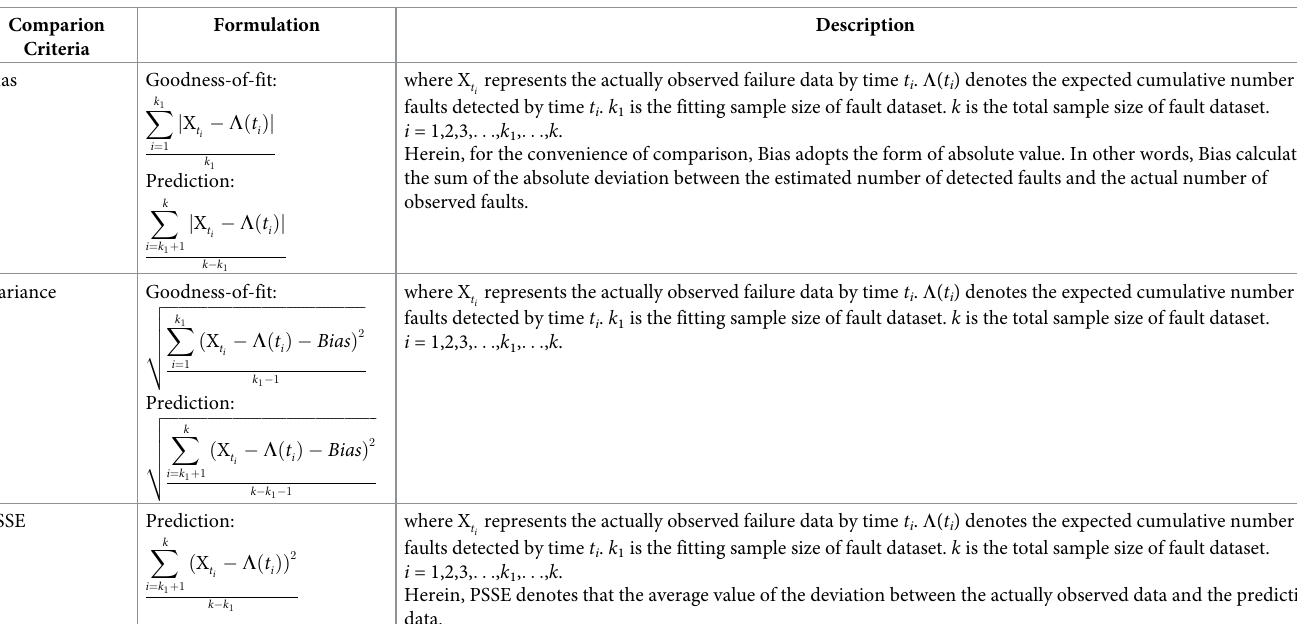
performance of the proposed model is stable, but other models are unstable. For example, the second is the Singh multi-release model-1 in Table 2, but the second is the Tandon multi- release model-3 in Table 4.